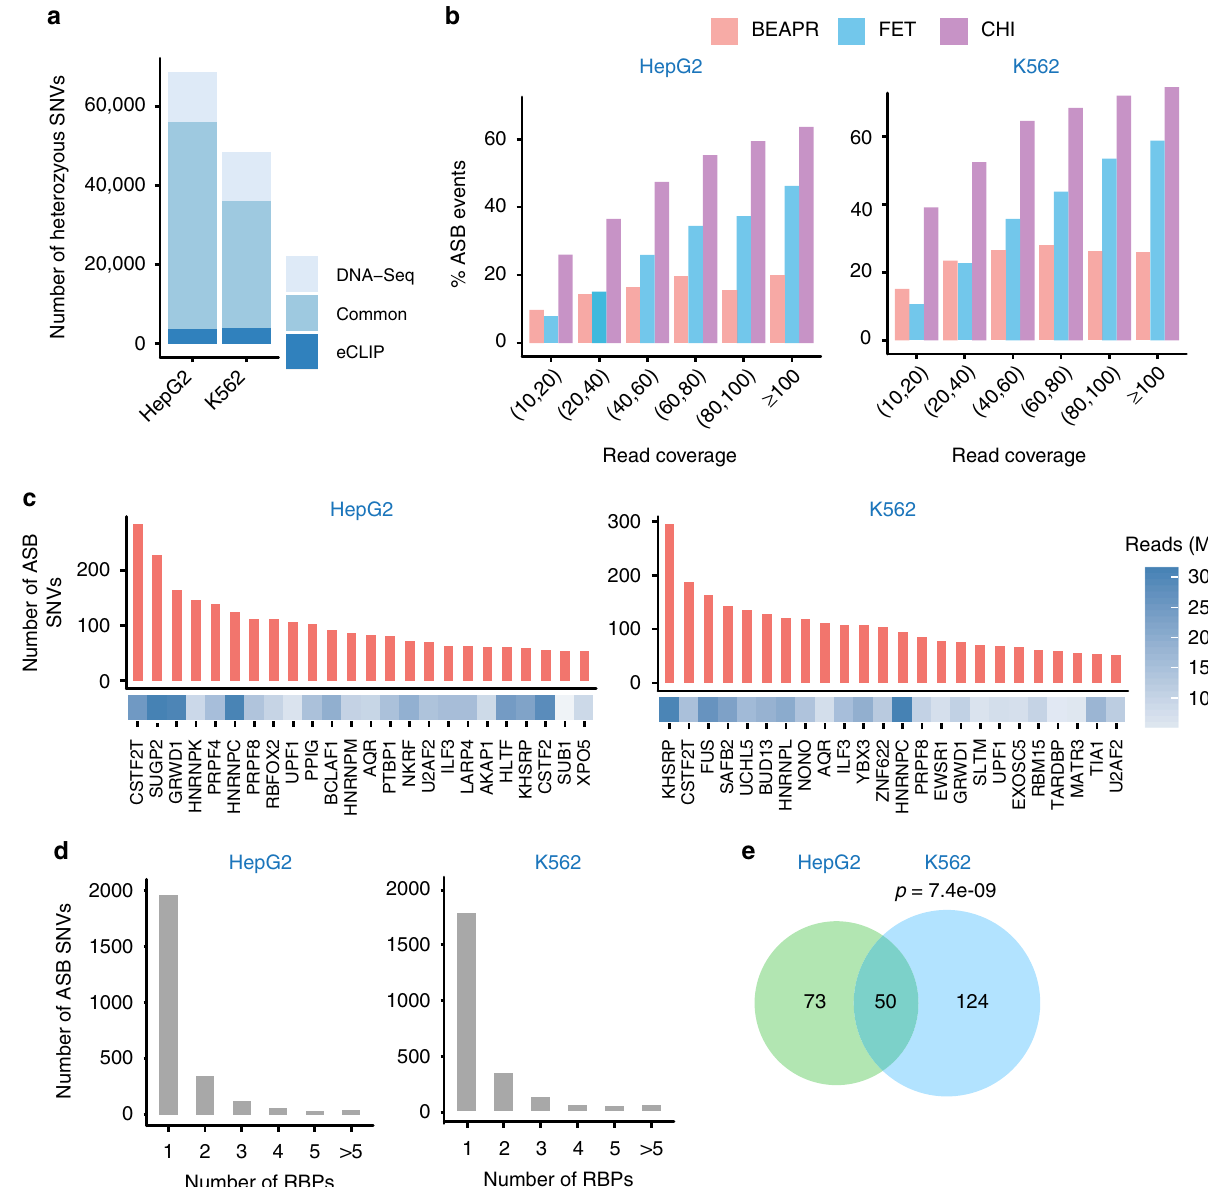
Fig. 2 Allele-speci fi c binding (ASB) events identi fi ed in the enhanced crosslinking and immunoprecipitation (eCLIP) data of HepG2 and K562 cells. a Number of heterozygous single-nucleotide variants (SNVs) identi fi ed via whole-genome DNA sequencing or eCLIP. Those that are common to both methods are illustrated. b Percentage of ASB events among all testable SNVs in each read coverage bin. The average read coverage of each SNV in the two replicated eCLIP experiments is shown here. A minimum read coverage of 10 was required. c Number of ASB events identi fi ed for each RNA-binding protein (RBP) in HepG2 and K562 cells. Only RBPs with ≥ 50 ASB events are shown. The number of usable eCLIP-Seq reads (in millions (M)) is shown for each RBP. d Number of ASB SNVs associated with one or more than one RBPs. e The overlap of ASB SNVs between HepG2 and K562. Only heterozygous SNVs common to the two cell lines are included. P value was calculated by Fisher ’ s exact test. (Source data are provided as a Source Data fi le) (RBNS) assay as part of the ENCODE project 9 . RBNS quanti fi es were located in close proximity to the k-mer enrichment peaks the binding speci fi city of an RBP to a k-mer sequence using the R (Fig. 3a – f). Interestingly, the fold enrichment of RBNS k-mers in value 18,19 . To focus on RBPs with relatively high binding speci- ASB regions relative to control regions is often higher for proteins fi city, we required an RBP to have at least one k-mer sequence with higher R values. These results strongly support the validity of with R ≥ 2. Among all RBPs with at least 50 ASB events and at the predicted ASB events. Note that the enrichment of RBNS least 30 events in annotated genes, fi ve RBPs, hnRNPC, hnRNPK, motifs was lower if no correction for crosslinking-induced bias hnRNPL, RBFOX2, and TARDBP, had RBNS k-mers that passed was carried out (Supplementary Figure 10), supporting the this requirement. For these RBPs, we analyzed the occurrence of importance of this step. We observed that the speci fi c nucleotide the RBNS k-mers in the fl anking regions of ASB SNVs. Com- position disrupted by the ASB SNVs varied for different RBPs (Fig. 3a – f), which may depend on the speci fi c binding property of were enriched with RBNS motifs, and, importantly, the ASB loci the RBPs and the speci fi c allelic sequences of ASB SNVs. NATURE COMMUNICATIONS| (2019) 10:1338